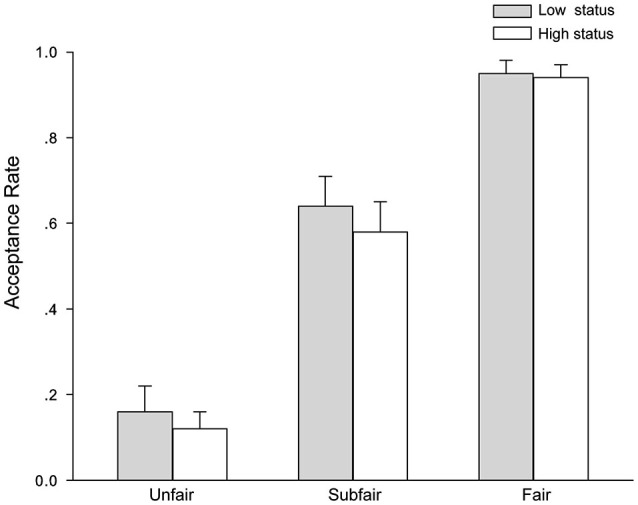
The acceptance rate depicted as a function of offer fairness and social status. Error bars represent standard errors of the means.